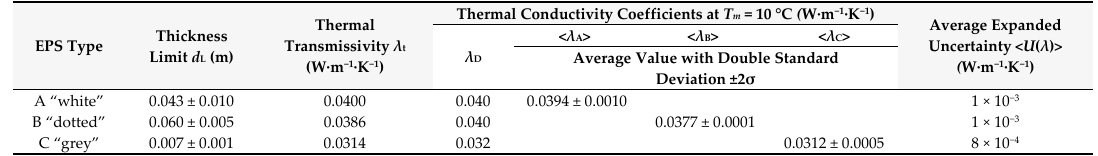
Table 3. Data concerning the thermal conductivity of the EPS A, B, and C products (thermal transmissivity declared and averaged coefficients, with corresponding thickness limits).